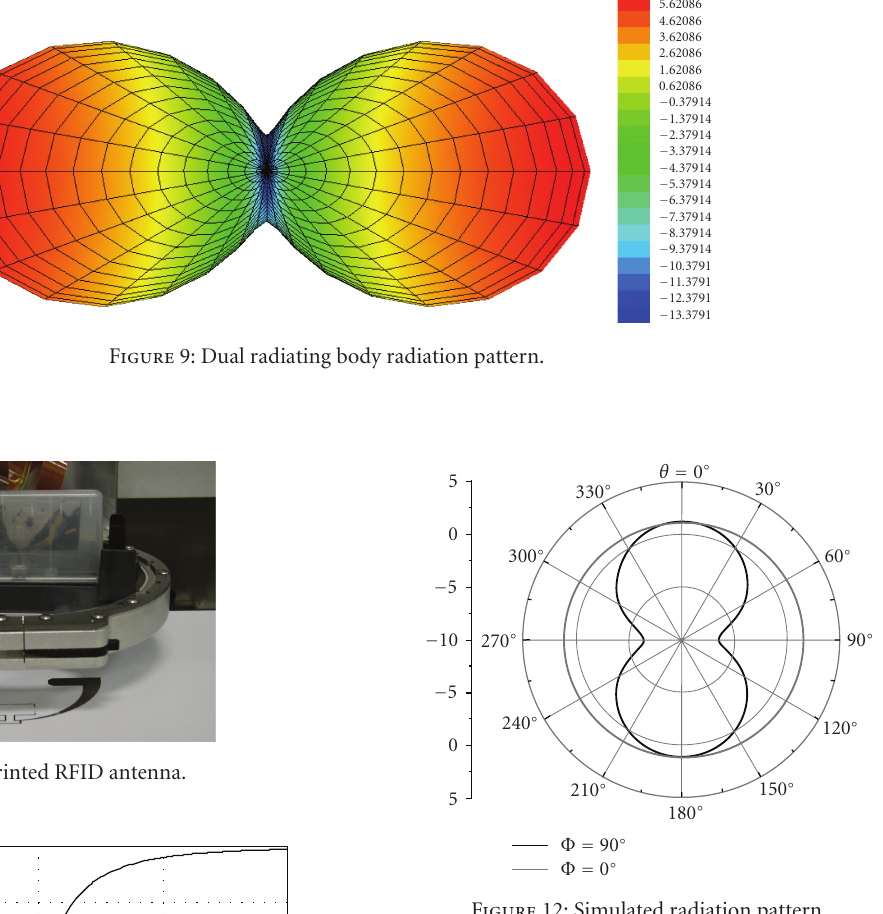
Figure 12: Simulated radiation